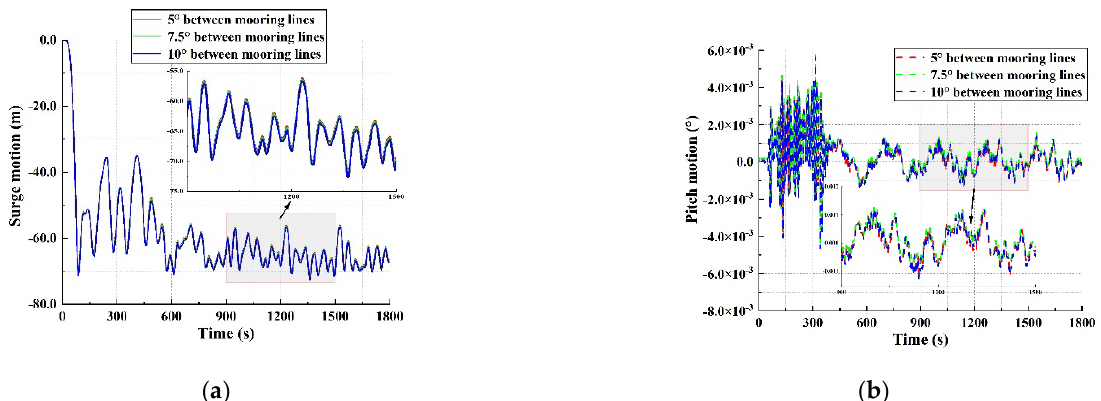
Figure 24. Comparison of three groups of mooring lines with angles of 5°, 7.5°, and 10°. ( a ) Surge motion under level ice loads; ( b ) pitch motion under broken ice floes loads.